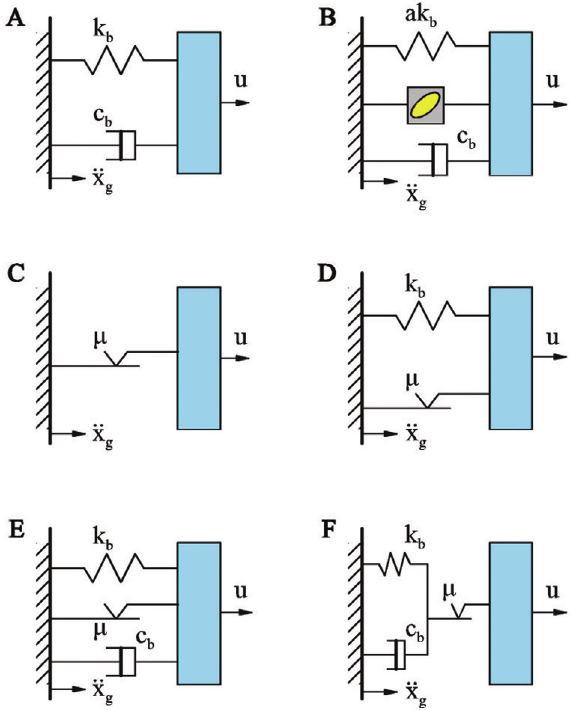
Figure 2: Schematic diagrams for laminated rubber bearings, N-Z, pure-friction, friction pendulum system, resilient-friction base isola- tor, and “Electric de France”